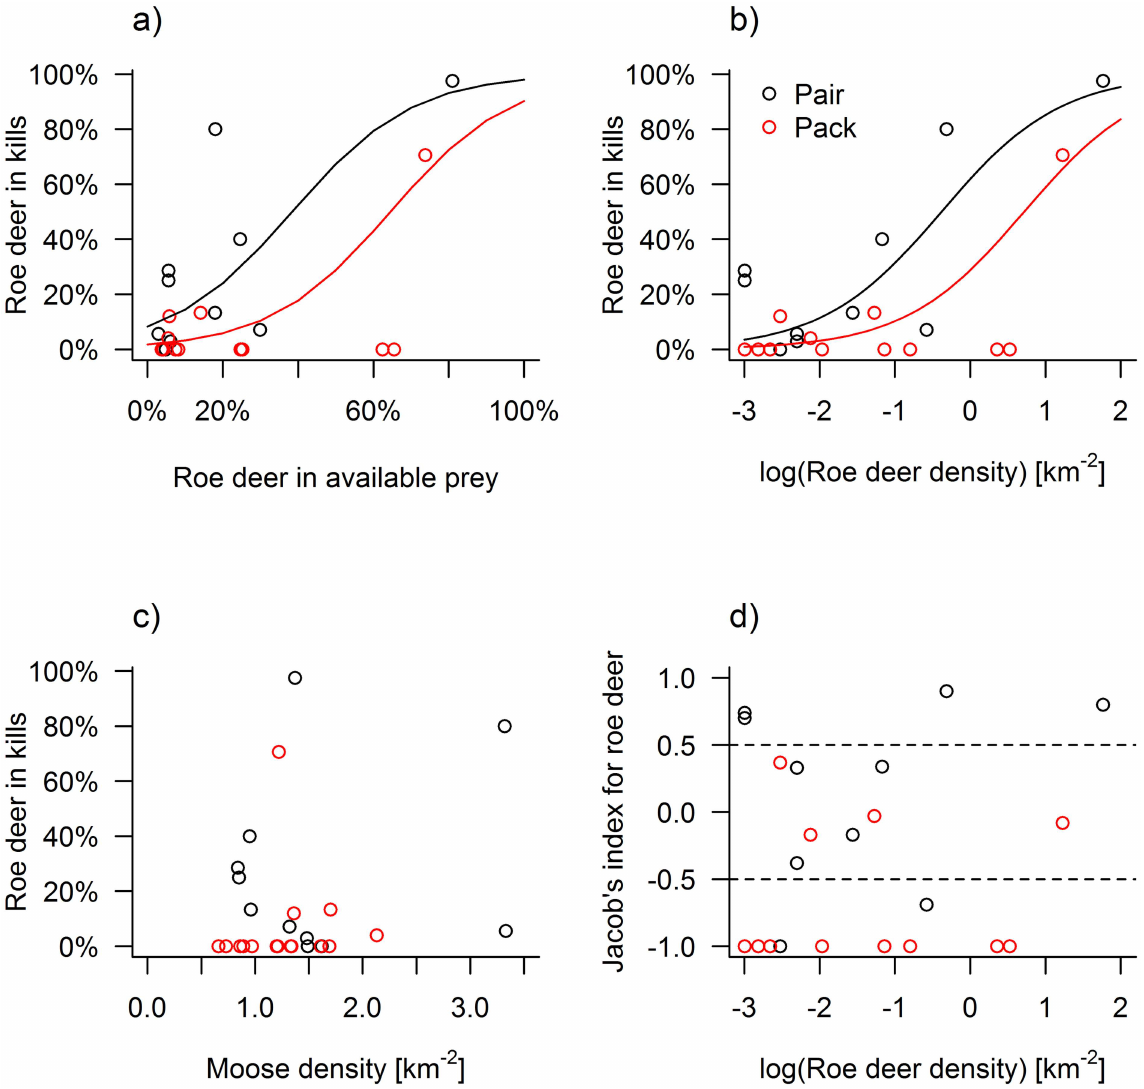
Fig 1. The proportionof roe deer out of the total numberof roe deer (n = 112) and moose (n = 297) killedby pairs (black) and packs ( (cid:21) 3, red) of wolves for 26 predationstudies in 17 wolf territories in Scandinavia in relationto (a) the estimated proportionof roe deer abundance, (b) the estimated density of roe deer, and (c) the estimated density of moose. Fig 1d plots the preferencefor roe deer in terms of the Jacob’sIndex (D) in relationto roe deer density. Stippledlines indicate threshold values, with avoidance D < -0.5 and preference D >